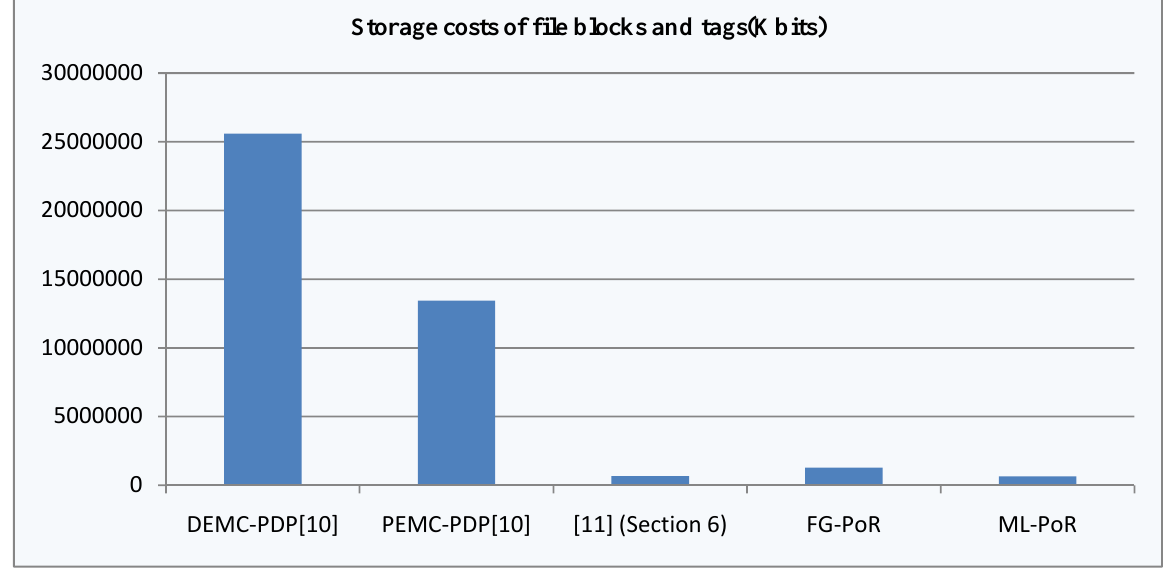
Figure 6. Storage costs of file blocks and tags of the five